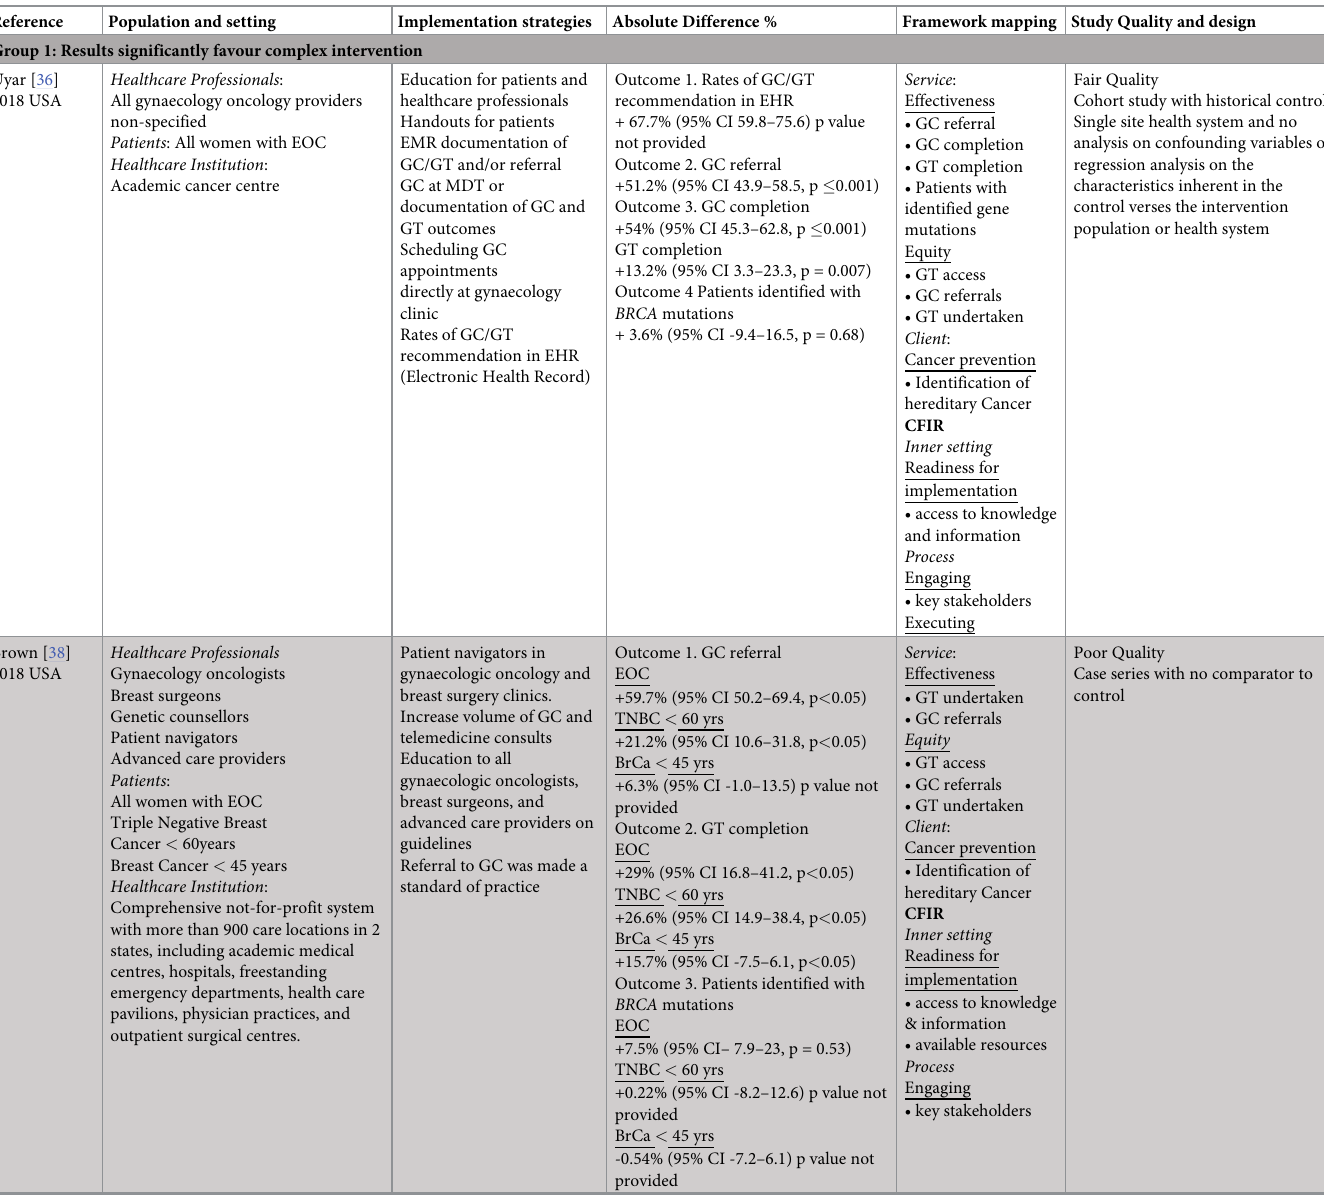
Table 4. Implementation strategies in the various health system and professional settings grouped by complex intervention effects results.